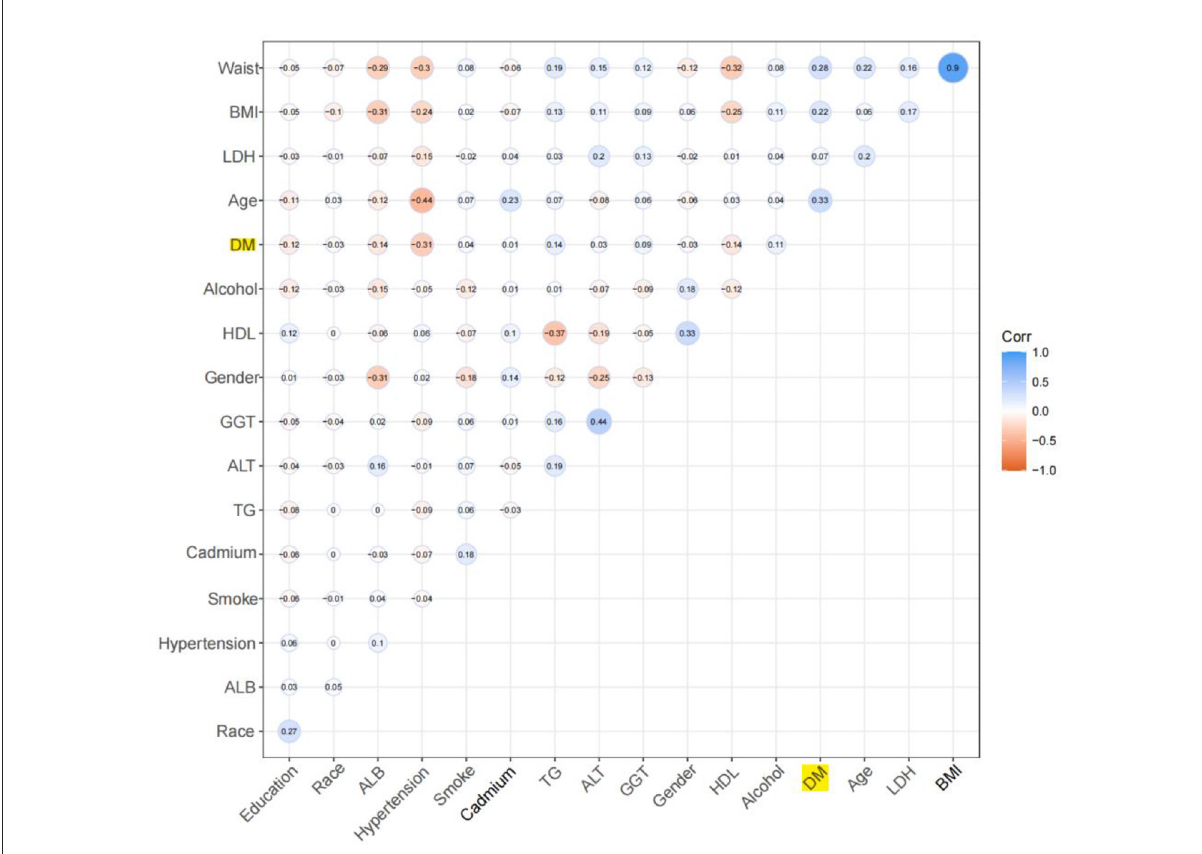
FIGURE2 Pearson correlation coefficient plot. With the decrease of Pearson’s r , the blue in the figure deepens, which means the negative correlation is stronger; with the increase of Pearson’s r , the red in the figure deepens, which means that the positive correlation is